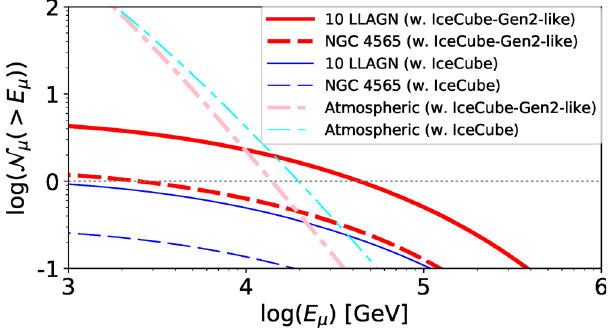
Fig. 5 The expected number of neutrino events with current and future detectors. We plot the expected number of through-going muon track events above a given muon energy for a 10-yr operation with IceCube (thin- blue) and IceCube-Gen2-like detector (thick-red). The solid lines are for the case that stacks the ten brightest LLAGN, and the dashed lines are for the brightest LLAGN, NGC 4565. The dotted-dashed lines show the expected number of the atmospheric background for the case that stacks the ten LLAGN. The dotted horizontal line indicates N μ ¼ 1 for comparison. Stacking more LLAGN does not help improving the detectability because the background also increases with the number of the stacked LLAGN 29 .